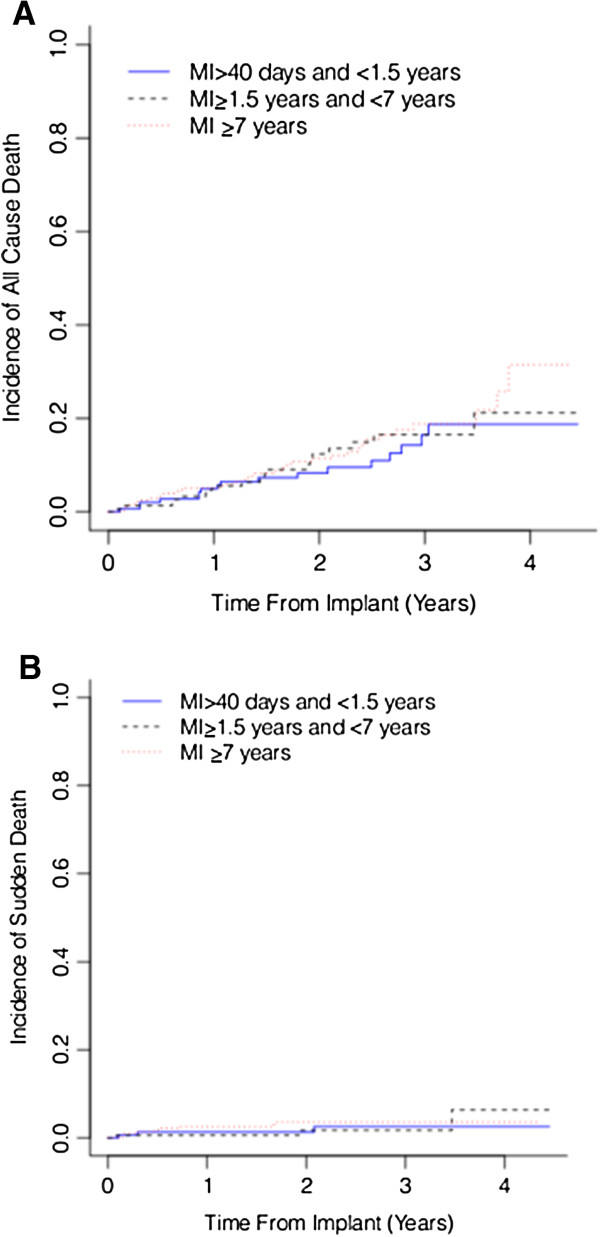
Cumulative incidence estimates of all cause mortality (panel A) and sudden cardiac death (panel B) in patients with a prior MI ≥7years (dotted red line), MI ≥ 1.5 years and <7 years (dashed black line) and MI >40 days and <1.5 years (blue line).